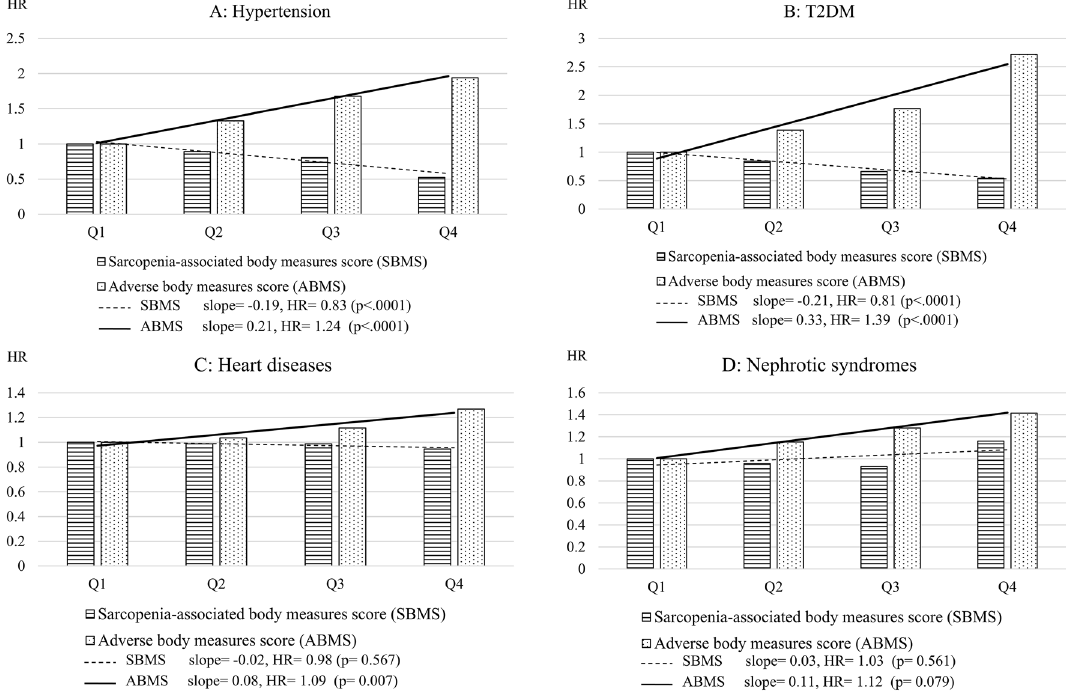
Figure 1. Comparison between sarcopenia-associated adverse body measures score (SBMS) and adverse body measures score (ABMS) in terms of their linear relationship with chronic diseases (the analyses were